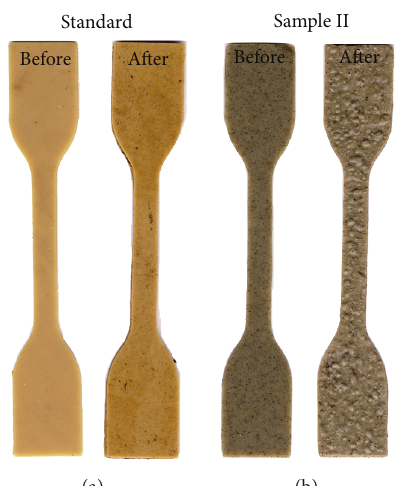
Figure 3: Biodegradation: (a) standard (after and before soil test), (b) sample II with keratin (after and before soil test).